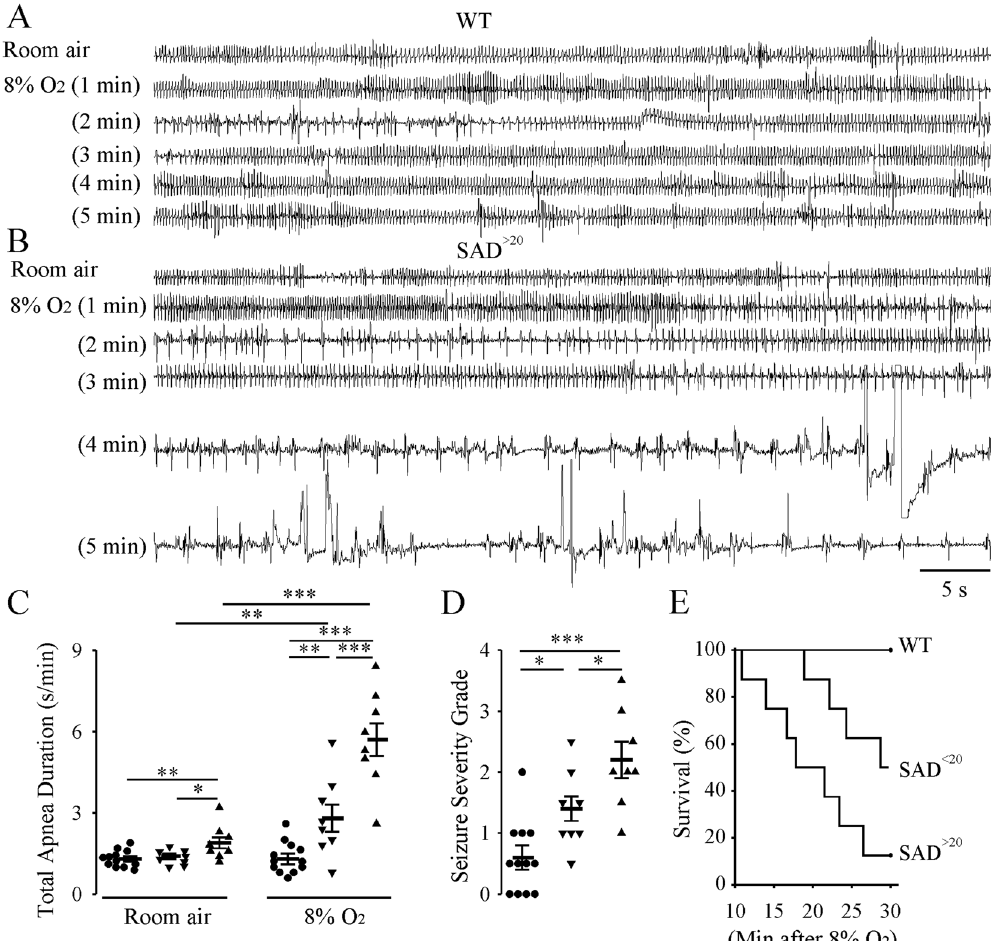
Figure 2. Abnormal respiratory activity in SAD pups at P7-P8 under normoxic and hypoxic (8% O 2 ) conditions. Representative plethysmographic recordings of respiratory pattern in P8 WT (A) and SAD > 20 (B) mice under normoxic (top trace) and hypoxic conditions. Note the induction of apneas and seizure-like activity after 3 minutes of hypoxia (3 rd trace) followed by gasping in SAD > 20 . Population data: ( C ) Total duration of apneas; ( D ) seizure severity grade during 5 min of 8% O 2 . * p < 0.05; ** p < 0.01; *** p < 0.001 using two-way RM ANOVA Holm-Sidak method for ( C ) and one way ANOVA Holm-Sidak method for ( D ). ( E ) Survival rate after exposure to 30 min of 8% O 2 using Kaplan-Meier Survival analysis (log-Rank; Holm-Sidak method; WT vs SAD < 20 : p < 0.01; WT vs SAD > 20 : p < 0.001; SAD < 20 vs SAD > 20 : p <